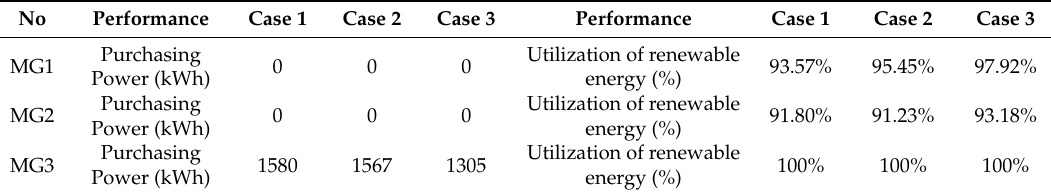
Table 4. Power exchange and utilization of renewable energy.